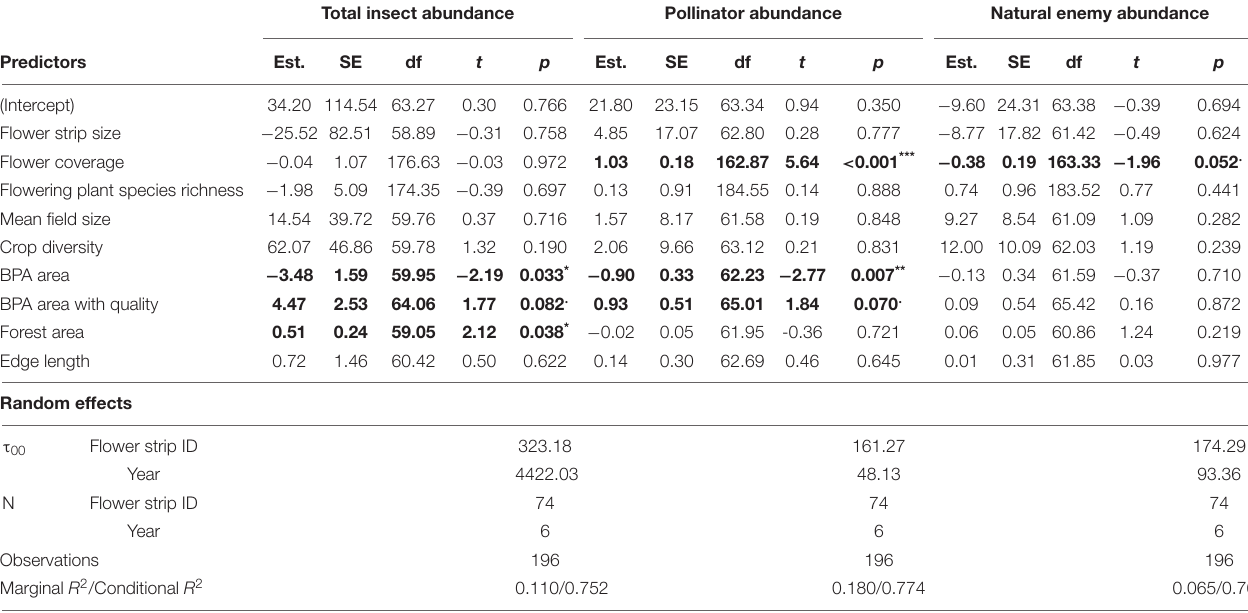
TABLE 3 | Summary of linear mixed-effects models for total insect, pollinator, and natural enemy abundance with estimates (Est.), standard errors (SE), degrees of freedom (df), t -values (t), and p -values (*** p < 0.001, ** p < 0.01, * p < 0.05, . p < 0.1) for all fixed effects. Total insect abundance Pollinator abundance Natural enemy abundance